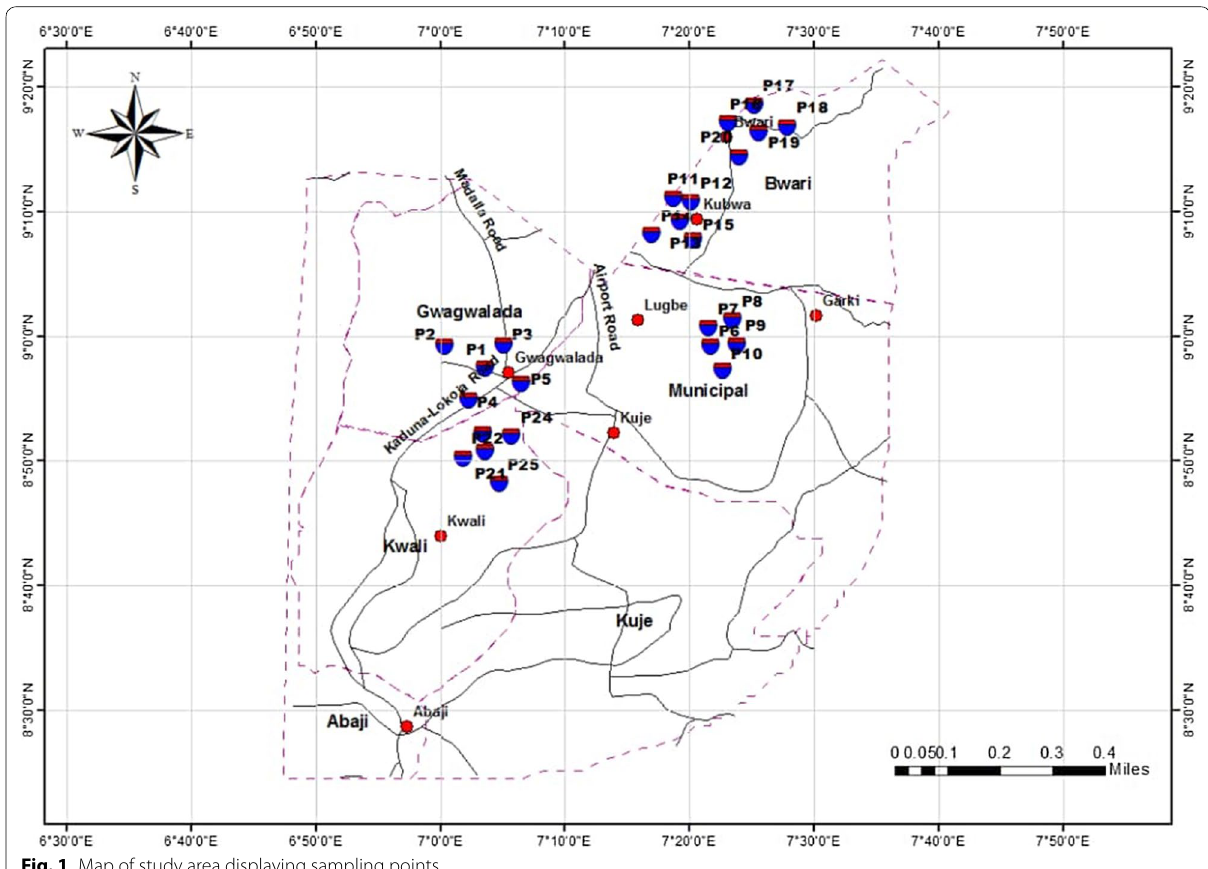
Fig. 1 Map of study area displaying sampling